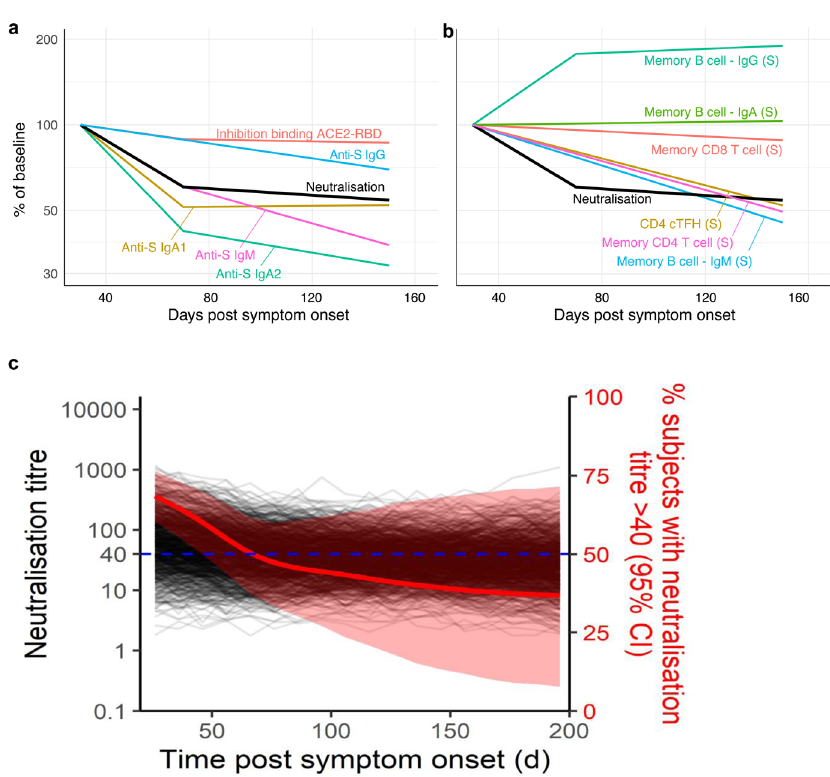
Fig. 5 Modelling of concomitant immune responses after COVID-19. a Rates of decay of serological neutralisation activity, ACE2 binding inhibition, and S- speci fi c IgG, IgM and IgA following recovery from SAR-CoV-2 infection. Baseline levels are set to 100% of that of the mean responses at visit 1 (median 40 days, shown in Fig. 1a). b Fitted Growth and decay rates for S-speci fi c memory T cell and B cell frequencies in PBMC. The neutralising antibody decay curve (black line) is shown for comparison purposes. c Simulation of elicitation and decay of serological neutralisation activity in 1000 individuals based on distributions observed in our SARS-CoV-2 convalescent cohort. The simulation was repeated 1000 times to estimate the proportion of individuals maintaining a neutralisation titre above 1:40 across multiple simulations (median and 95% con fi dence intervals shown in red). Source data are provided as a Source Data fi